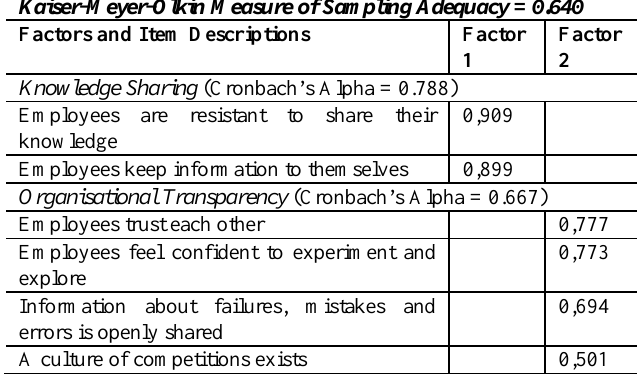
Table 1: Principle component analysis –